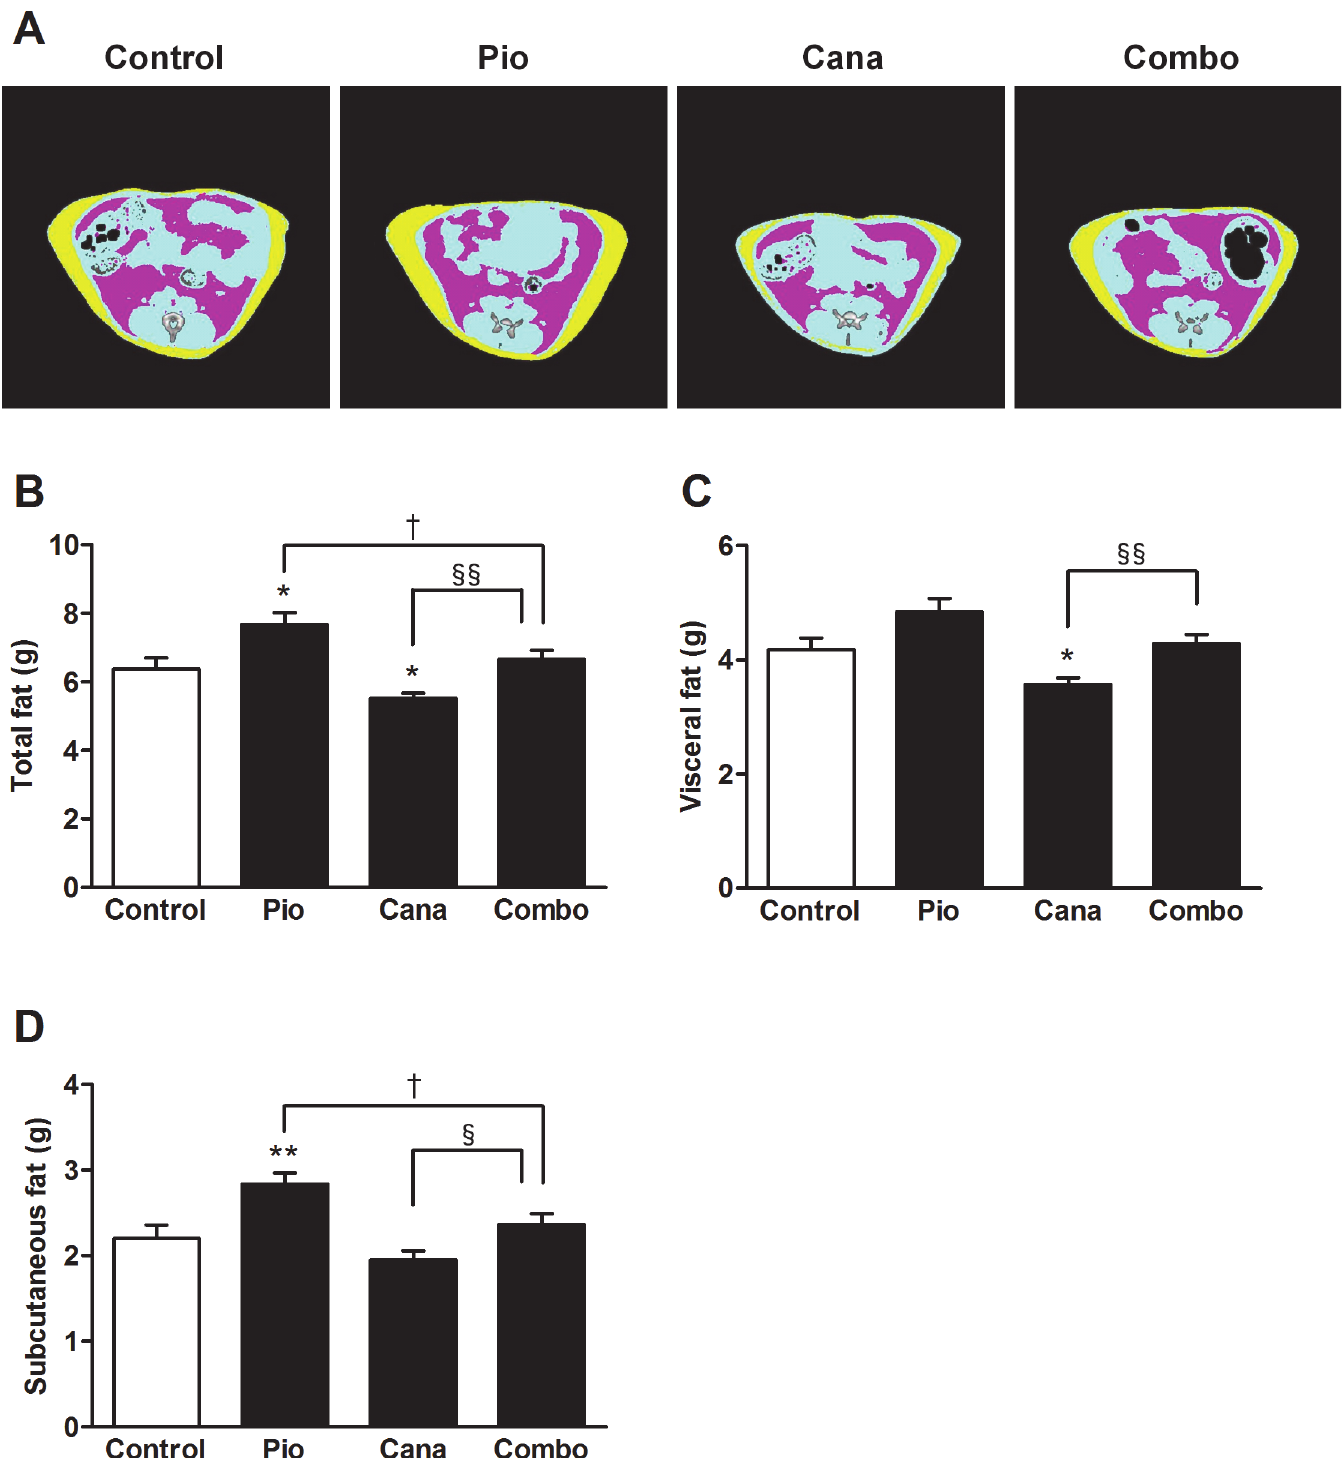
Figure 3. Body fat analysis by computed tomography (CT) in KK-A y mice. A: Representative CT images (red, visceral fat; yellow, subcutaneous fat), B: Total fat, C: Visceral fat, and D: Subcutaneous fat. Canagliflozin (Cana; 0.01% w/w food admixture), pioglitazone (Pio; 0.01% w/w food admixture), and their combination (Combo) were administered for 2 weeks. Adipose tissue weight was measured at the end of the study using an experimental animal CT system. Data are expressed as mean ± SEM (n = 7 – 8). * P < 0.05, ** P < 0.01 vs. control, † P < 0.05 vs. Pio, § P < 0.05, §§ P < 0.01 vs. Cana.